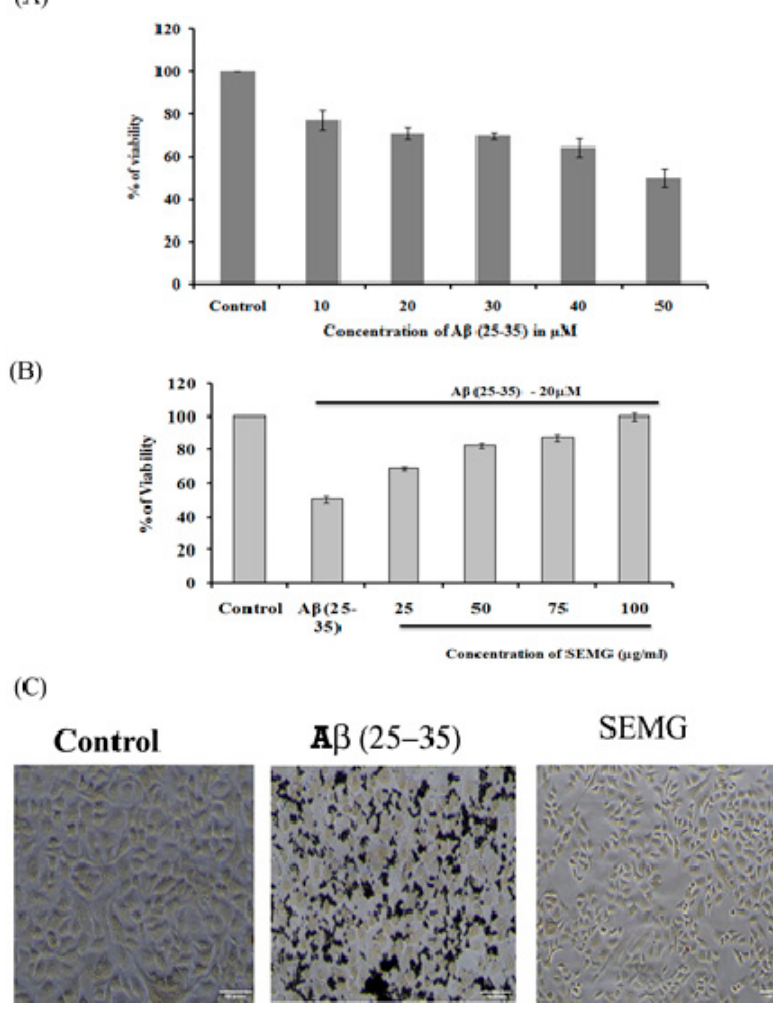
Figure 6. ( A ) Assessment of in vitro cytotoxic effect of Beta amyloid peptide (A β (25–35)) (10-500 μ M) in Neuro2A cell lines; ( B ) Evaluation of protective effect of SEMG against A β (25–35) induced toxicity; ( C ) Phase contrast microscopic analysis to assess the morphological changes induced by A β (25–35) toxicity with magnification 20 ×.